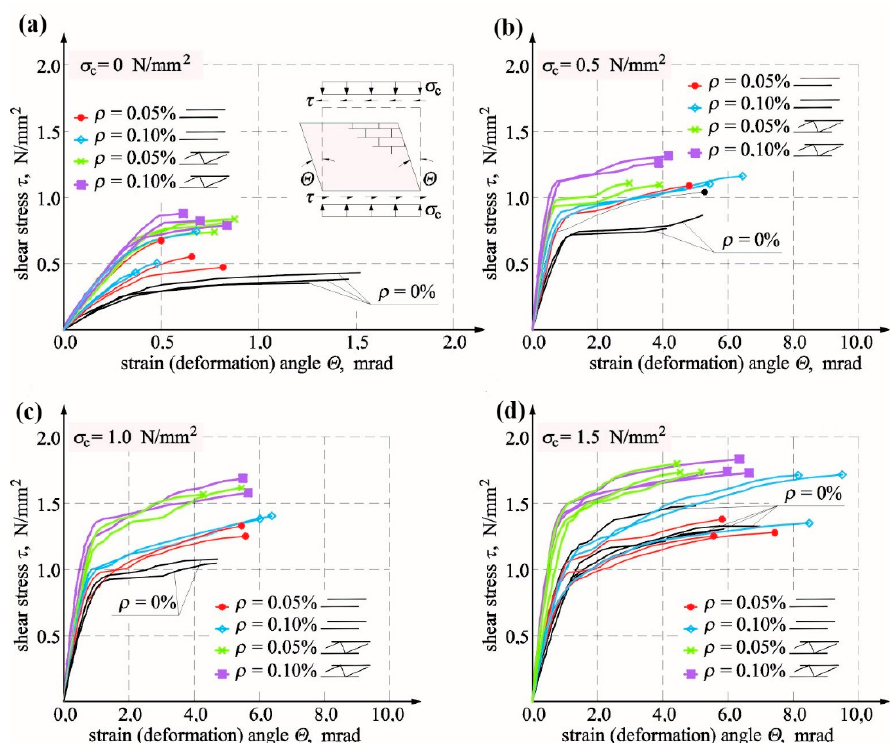
Figure 10. Relationships τ − Θ for unreinforced and reinforced units made of solid brick tested at different values of initial compressive stress: (a) σ c = 0, (b) σ c = 0.5 N/mm 2 , (c) σ c = 1.0 N/mm 2 , and (d) σ c = 1.5 N/mm 2 .